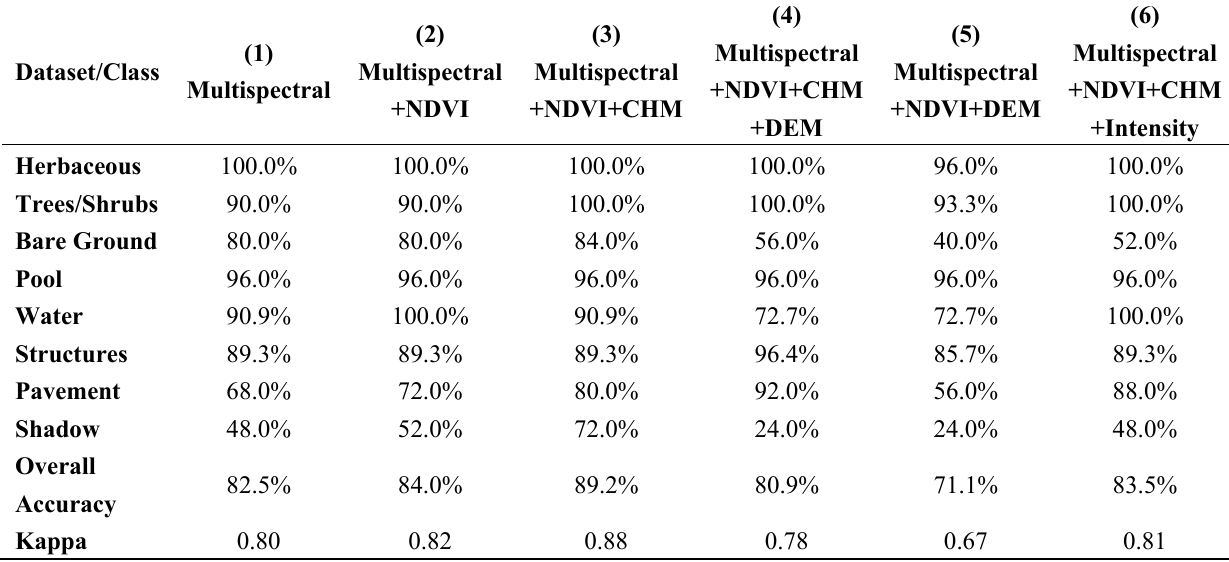
Table 1. Producer’s Accuracy, Overall Accuracy, and Kappa for each of the iterations representing different input variables for each of the LULC